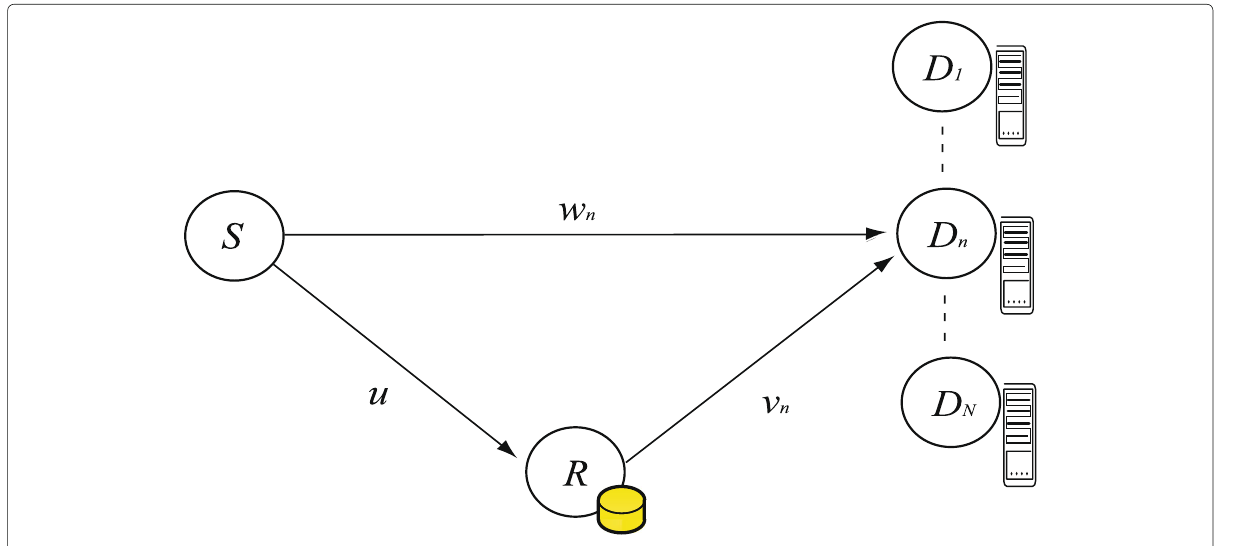
Fig. 1 Cache-aided mobile edge computing